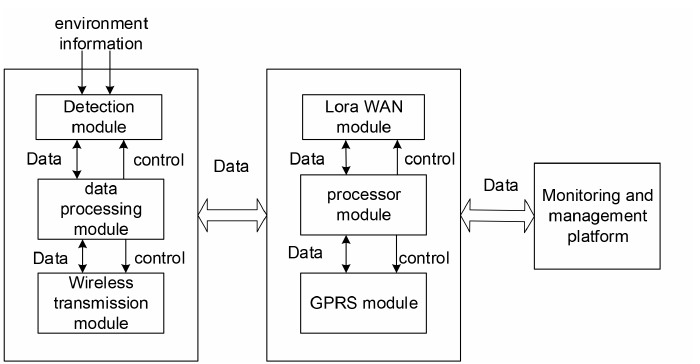
Figure 6. The architecture of remote monitoring